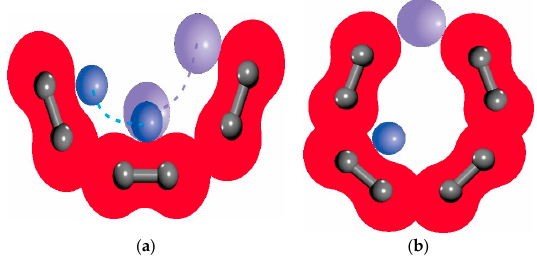
Figure 3. Principles of molecular measurement using probe molecules with different scales. ( a ) Probe surface difference with different radius measurements. ( b ) Measurement of volume differences by probe molecules with different radius sizes.